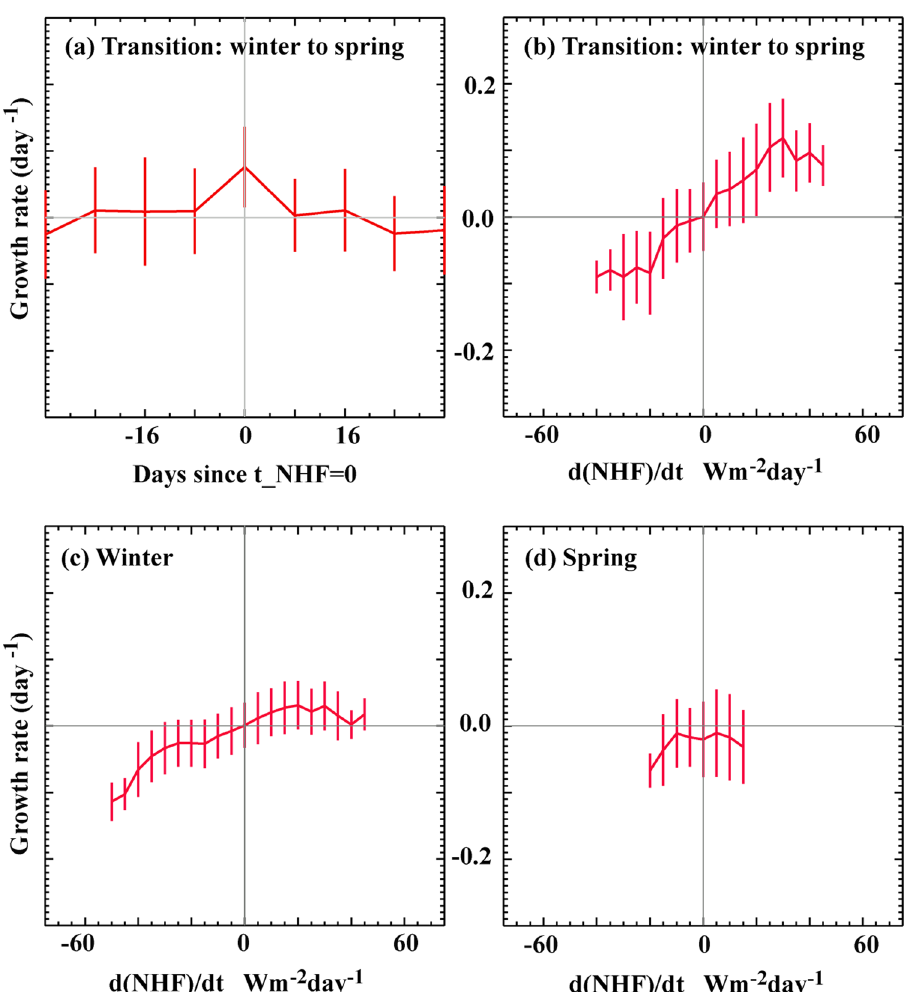
Figure 3. SChl net growth rate (in day −1 ) ( a , b ) during the winter to spring transition phase: when the NHF changes sign, ( c ) during the unstable winter phase: when NHF are initially negative and remain negative and ( d ) during the stable spring phase: when NHF is initially positive and remains positive. ( a ) SChl net growth rate is shown against time (in days) since the NHF has switched from negative to positive and has remained positive thereafter (t_NHF = 0). The mean net growth at t = 0 is larger than at any time step before (t = − 24d, − 16d, − 8d) or after (t = 8d, 16d, 24d). ( b – d ) SChl net growth rate against temporal changes in NHF. Positive (resp. negative) changes in NHF are used as a proxy for increased (resp. decreased) vertical stability. In winter and early spring, increased (resp. decreased) vertical stability at weekly time scale are associated with enhanced (resp. decreased) net growth rate. SChl Growth rates are computed for individual events, i.e. at each 8-day time step and at each 0.125° × 0.125° pixel in the bloom region over 1998–2017 within the time period January–April, and are then bin-averaged, with the vertical bars representing one standard deviation. Data of each single event before bin- averaging are shown in Supplementary Figure